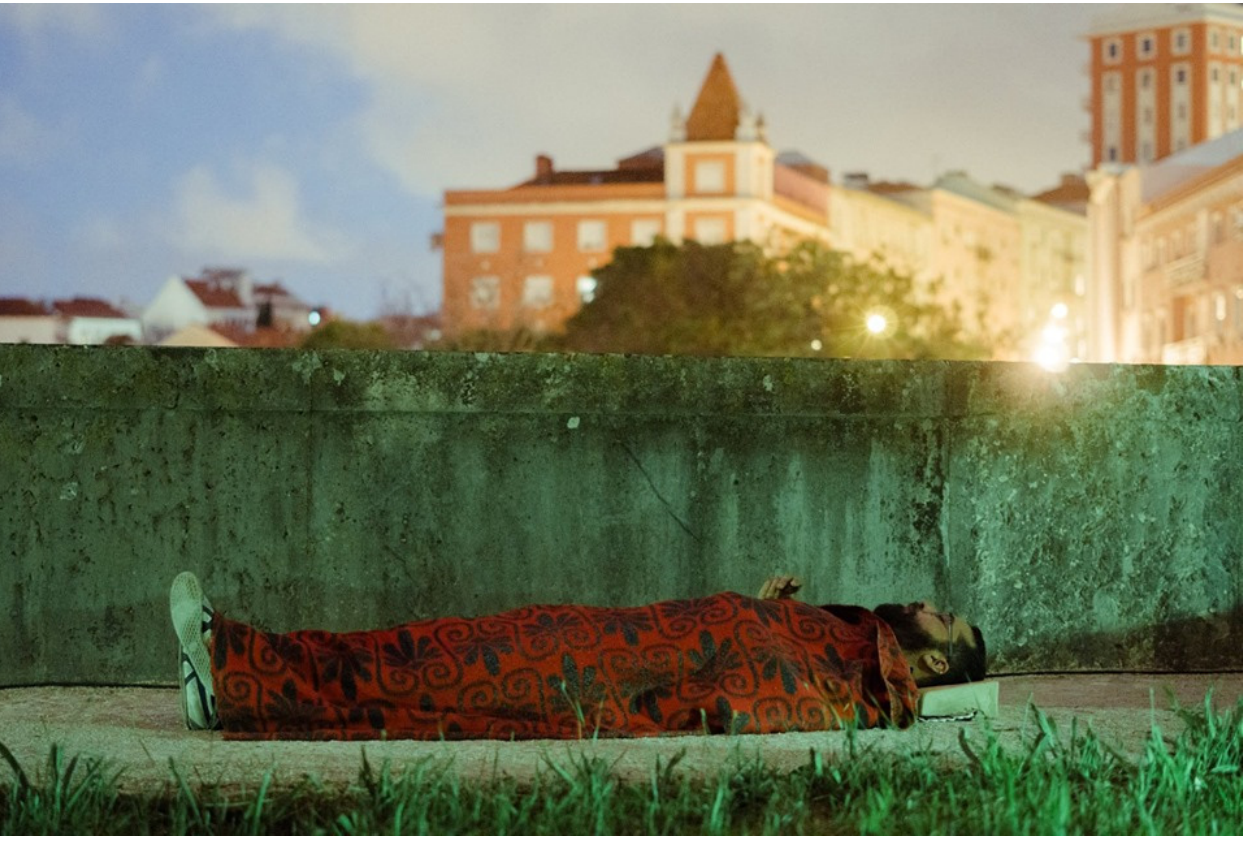
Figure 7. Place of Lulling . Visitor laying down while the sun is going down in the city. Mãe d’Água das Amoreiras Reservoir, Lisbon, 2019. © Joana Linda.